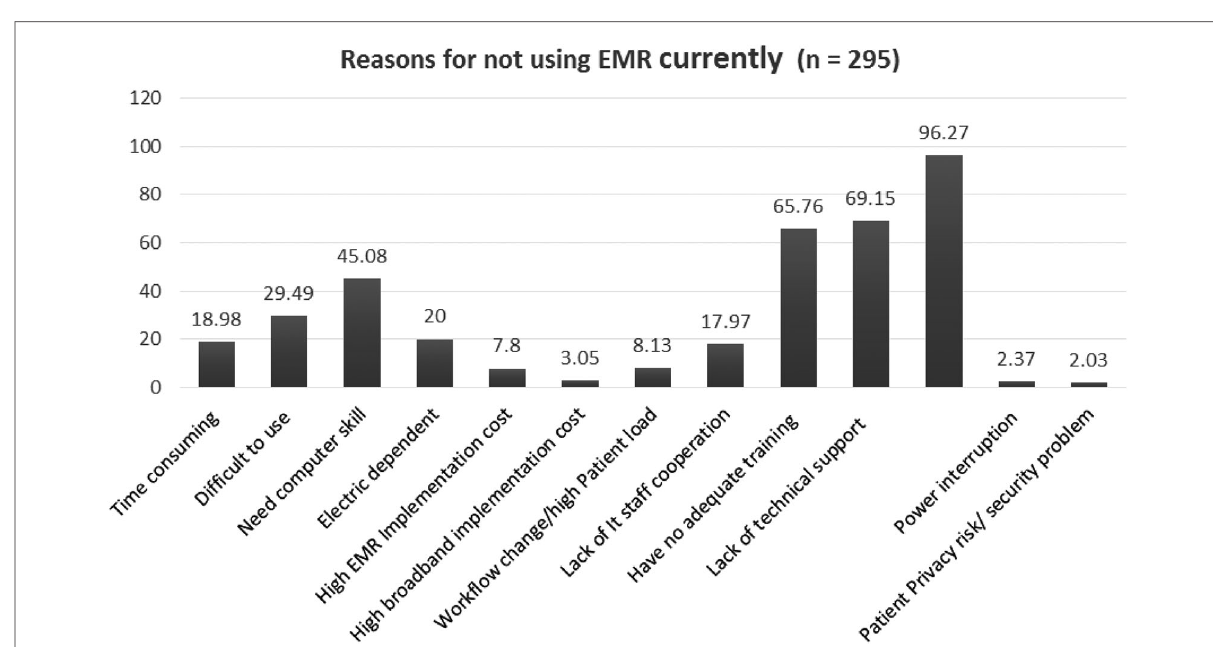
FIGURE 2 Reported reasons for not currently using the EMR system Dire Dawa, Ethiopia,